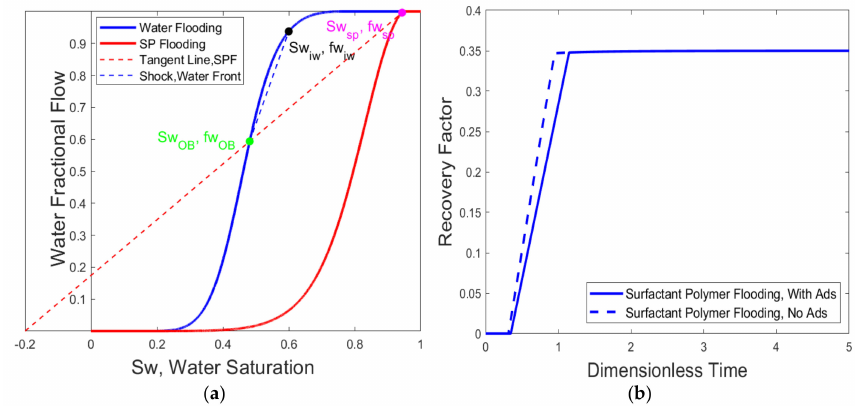
Figure 23. ( a ) Construction of shock front for water flooding and surfactant / polymer flooding, with adsorption; and ( b ) Comparison of cumulative oil recovery during SP flooding, between no adsorption and D i =